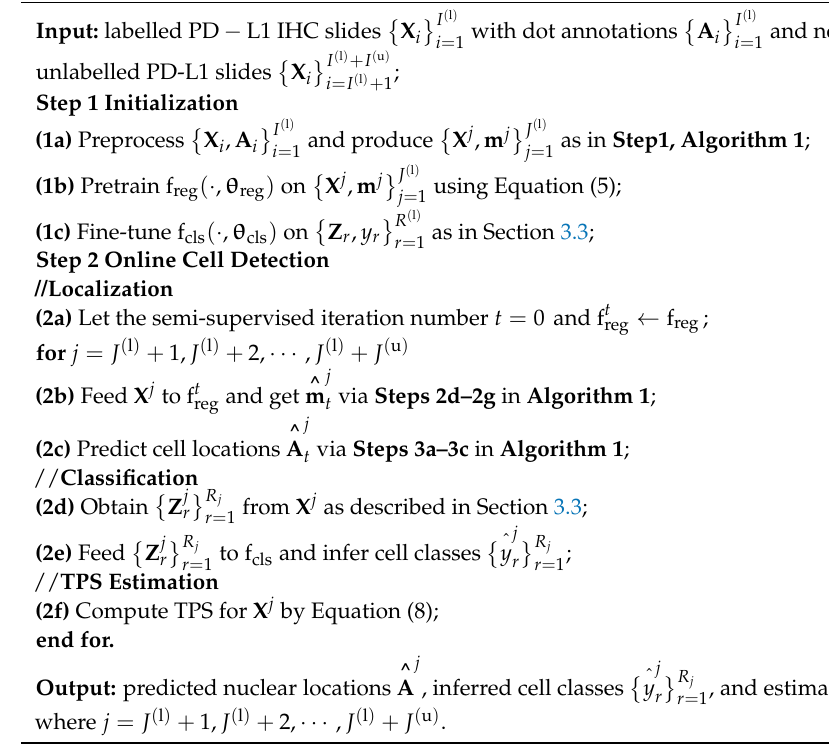
Algorithm 2 Online cell detection by GeoNet and TPS estimation with PD-L1 IHC